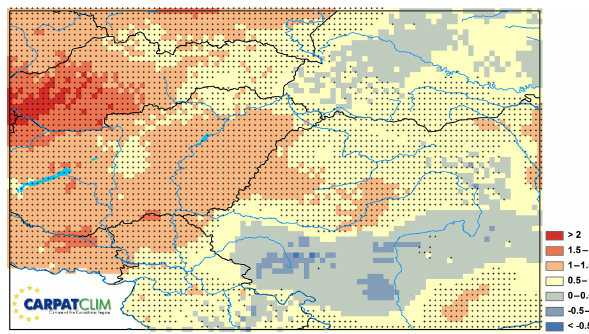
Figure 5. The slope of the fitted linear trend (mmyr − 1 ) to the an- nual of ET 0 for the period 1961–2010. The significant trends at α = 0 . 1 significance level are marked with